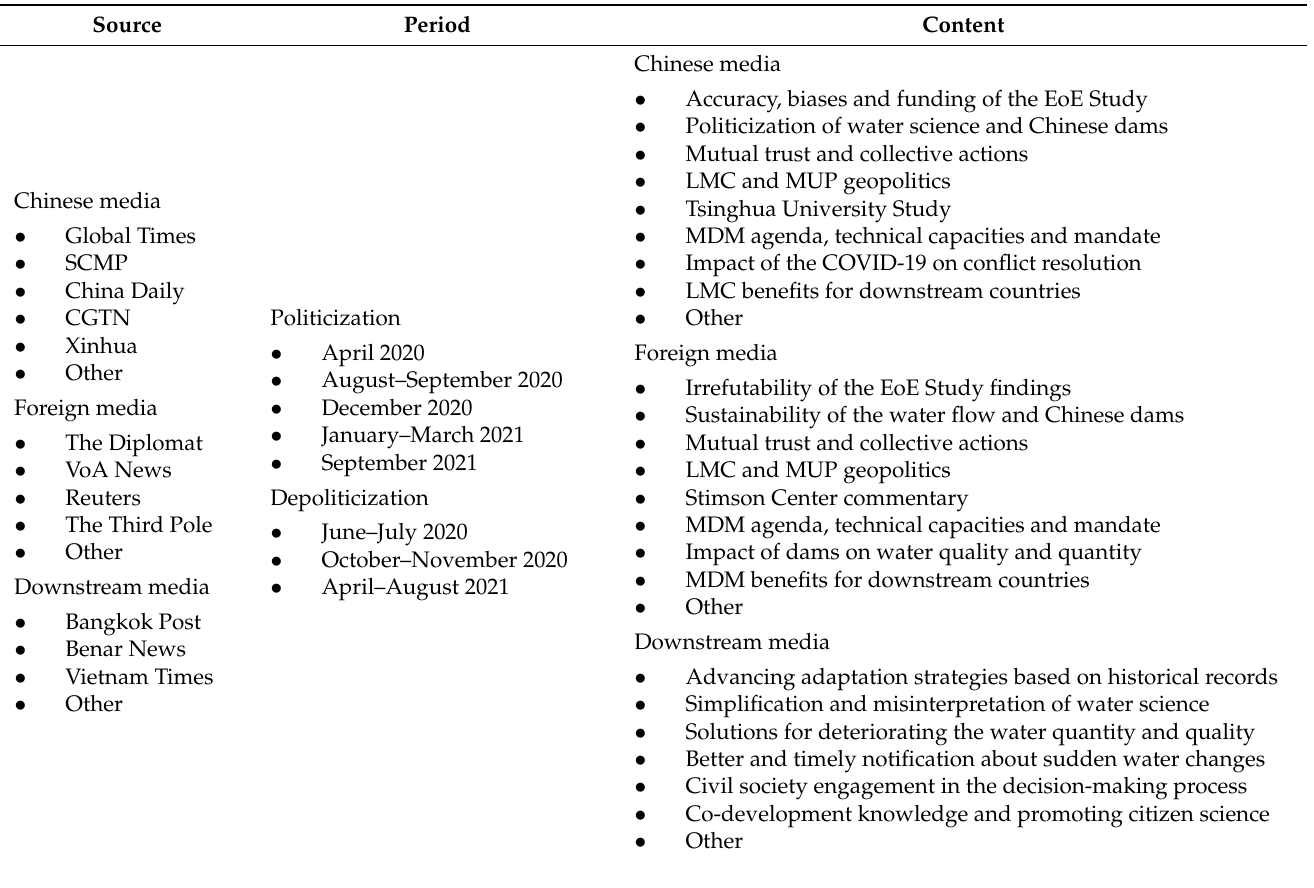
Table 5. List of civil society and other inputs discussing the Chinese mainstream dams